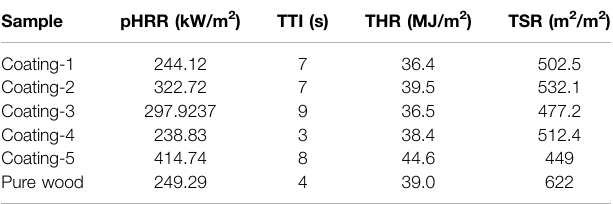
TABLE 2 | Cone calorimetry